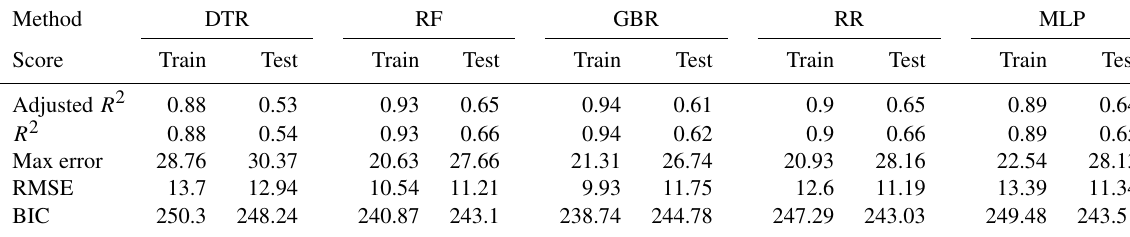
Table A4. Training and test scores on annual basis for the elderly population. Method